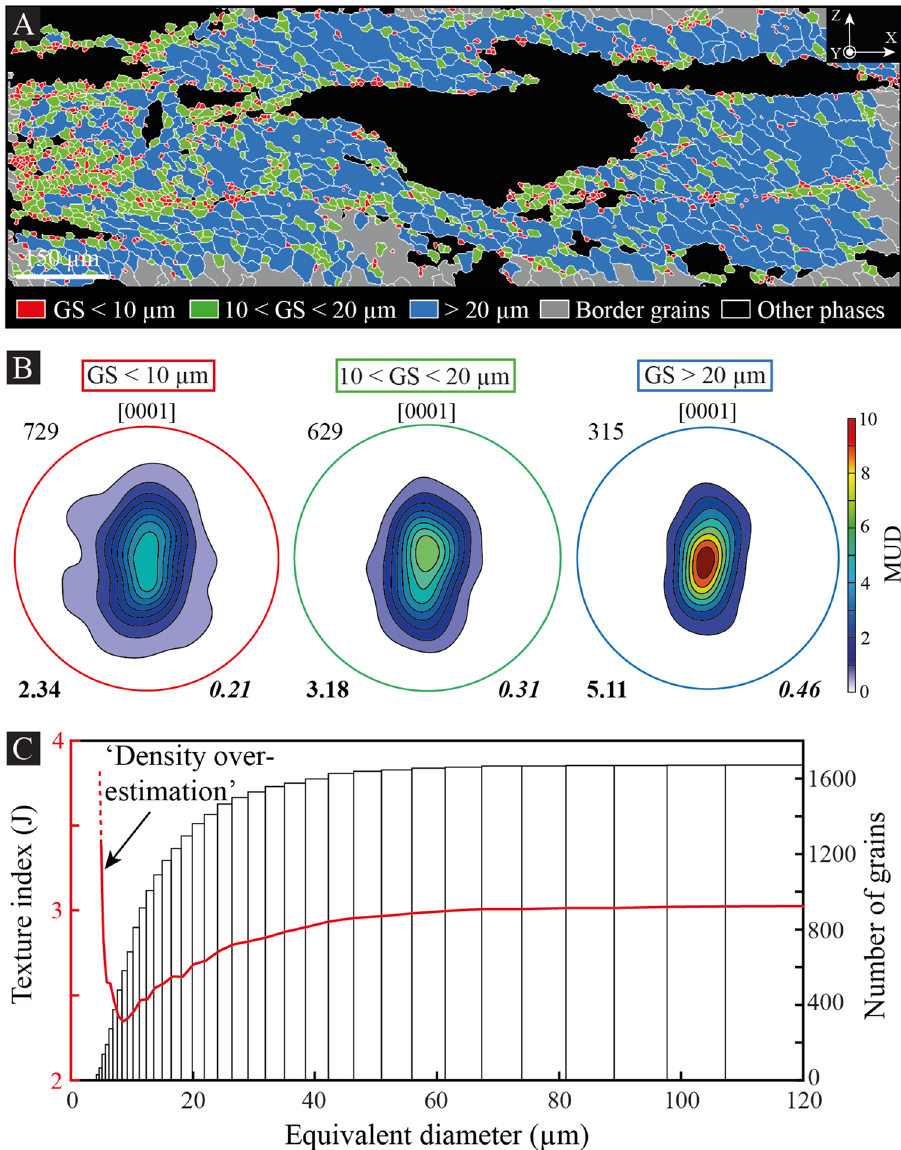
Figure 7. Texture strength dependency on grain size. ( A ) EBSD map of the shear band from grade 5 shown in Fig. 5A,B. Only quartz of the shear band center is shown for three categories of grain size (GS; equivalent diameter): (1) lower than 10 μm; (2) between 10 and 20 μm; and (3) above 20 μm. Grains cut by the map frame (i.e., borders grains) and grains composing myrmekite areas are not considered. X shear direction; Y cardinal axis; Z pole to shear plane. ( B ) Lattice-preferred orientation of each class of grain size. Only the [0001] c axis is shown in lower-hemisphere pole figures, together with the number of grains (top left in regular), texture (J) index (bottom left in bold) and misorientation (M) index (bottom right in bold italic). MUD multiples of uniform distribution. ( C ) Equivalent diameter versus J index for several populations of quartz grains sorted by ascending grain size and using a cumulative approach (the same graph using M index is available in Supp. Fig. 4). The histogram gives the number of grains in each class. As highlighted in ( B ), the J index distribution using a cumulative approach confirms a positive dependency on grain size, except below 8 μm where J describes an abrupt opposite behavior due to density overestimations (see text and ‘Method’